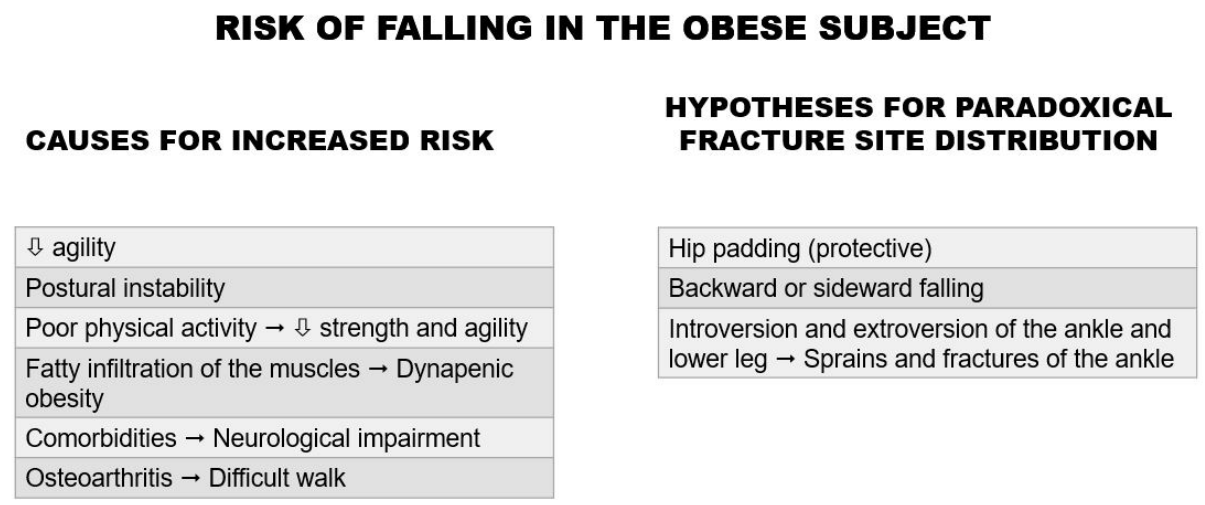
Figure 1. Risk of falling in the obese subject. In the table on the left, the possible causes for the increased risks of falling in the obese subject are listed. In the table on the right, the hypotheses for the paradoxical fracture location are illustrated.